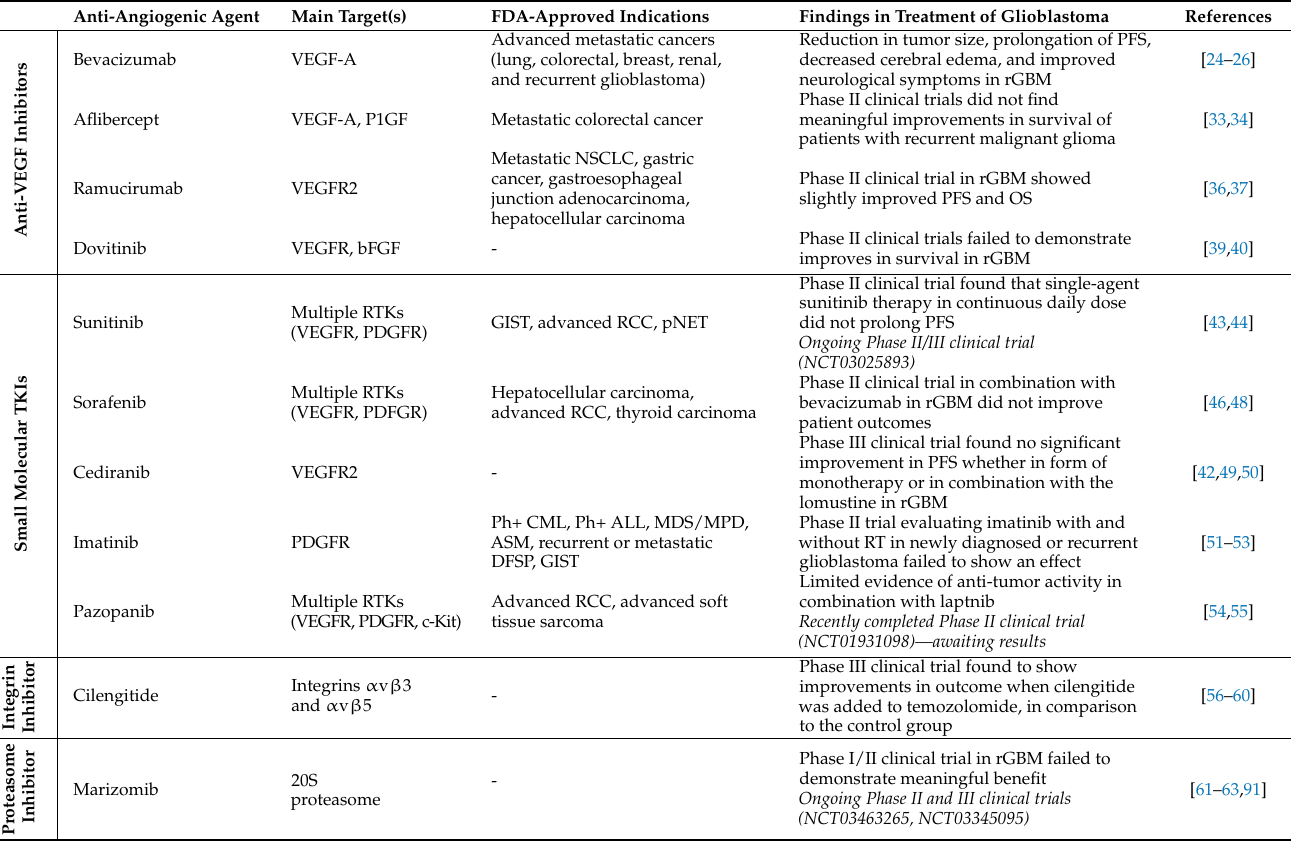
Table 1. List of current anti-angiogenic drugs for the treatment of various cancers and their respective study findings in the treatment of glioblastoma.